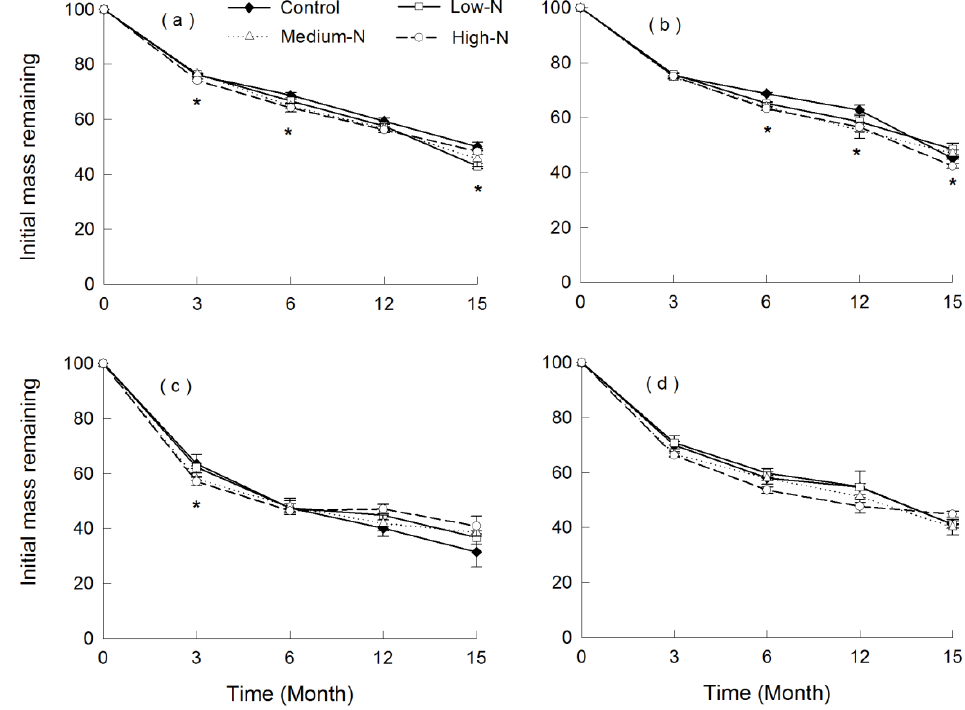
Figure 2. Percentagesof mass remaining (%) in the different N addition treatments for each leaf litter. ( a ) Chinese pine litter in the plantation; ( b ) Chinese pine litter in the natural forest; ( c ) Mongolian oak litter in the natural forest; and ( d ) Pine-oak litter in the natural forest. Error bars represent the standard errors of the means ( n = 3). Asterisk indicates significant difference at least between two treatments at p < 0.05.